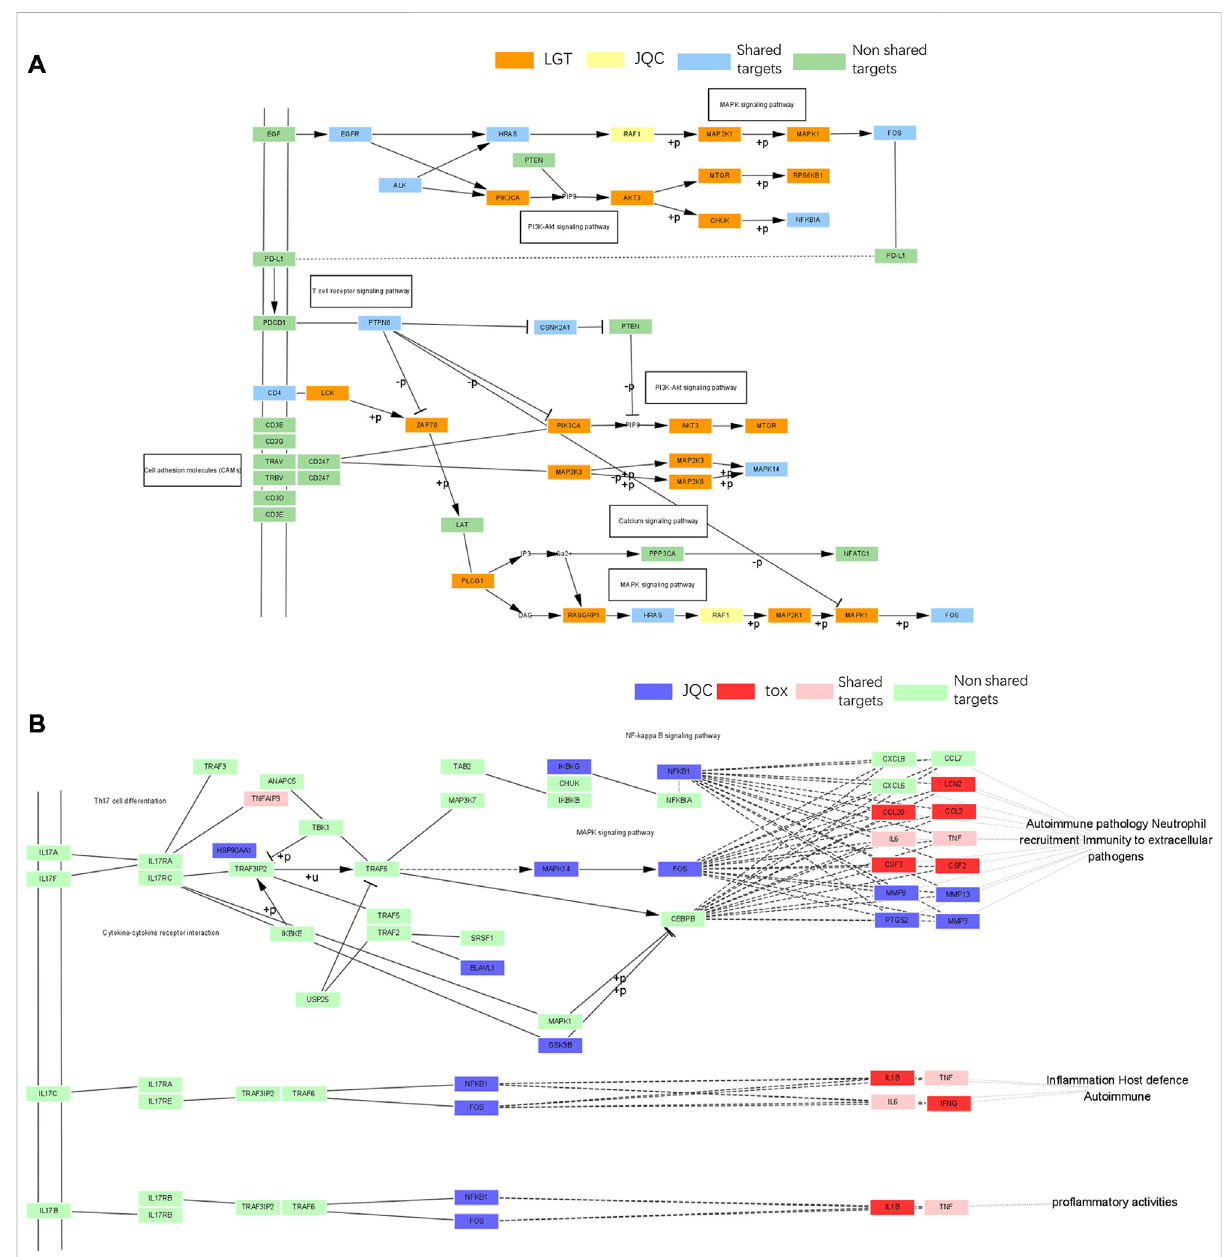
FIGURE 9 Gene enrichment pathways analysis of ef fi cacy-toxicity network of LGT. (A) Gene enrichment pathways analysis of from LGT and JQC respectively; (B) Gene enrichment pathways analysis of JQC and LGT toxic targets.